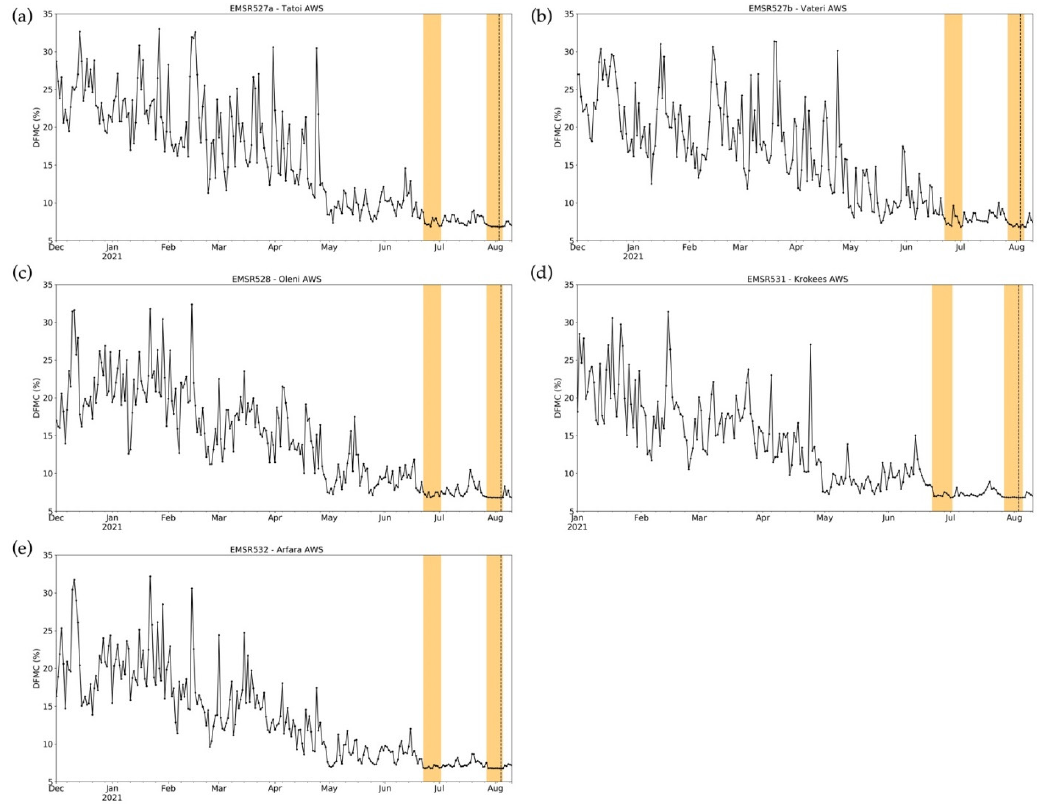
Figure 4. Time series of the daily DFMC for the period December–August: ( a ) Tatoi AWS-EMSR527a, ( b ) Vateri AWS-EMSR527b, ( c ) Oleni AWS-EMSR528, ( d ) Krokees AWS-EMSR531, and ( e ) Arfara AWS-EMSR532. The yellow-shaded areas delineate heatwave periods.